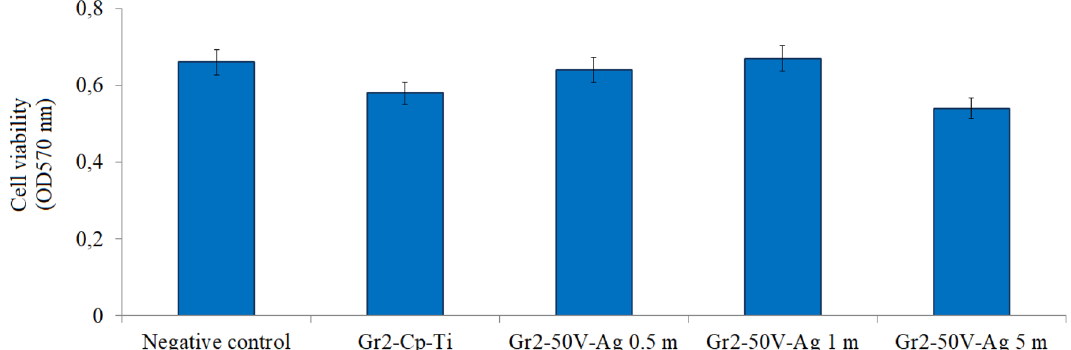
Figure 6. MTT test results of bare Gr2 and AgNPs-deposited nanotube surfaces. Different letters shown in the graph indicate statistical significance (p < 0.05).